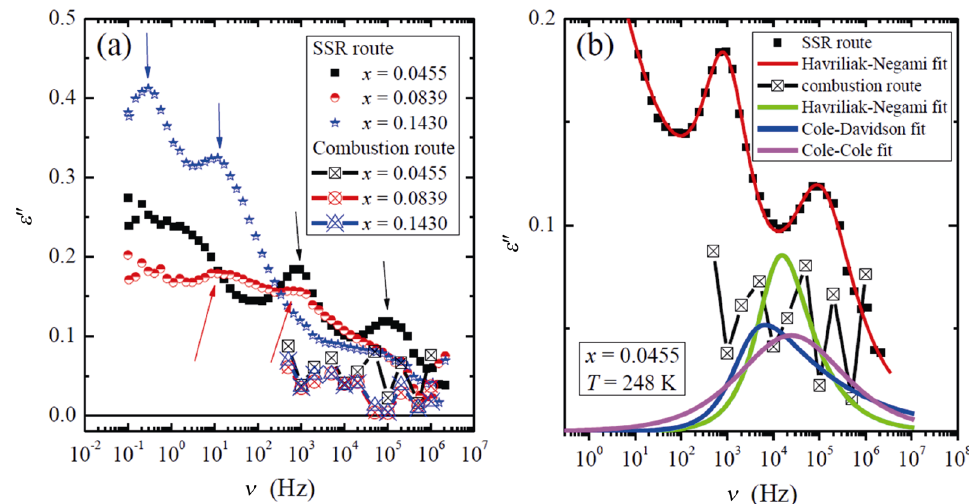
Fig. 11 (a) Dependence of ε  ( v ) at temperature of 248 K and different Gd 3+ concentrations for Pb 1–3 x (cid:0) x Gd 2 x (MoO 4 ) 1–3 x (WO 4 ) 3 x samples synthesized via solid state reaction (SSR) route and via combustion method. Arrow indicates position of the relaxation processes. (b) Dependence of ε  ( v ) at temperature of 248 K and concentration x = 0.0455, for samples synthesized via solid state reaction (SSR) method and via combustion route. Solid curves represent fits by various fitting functions used to parameterization of the relaxation